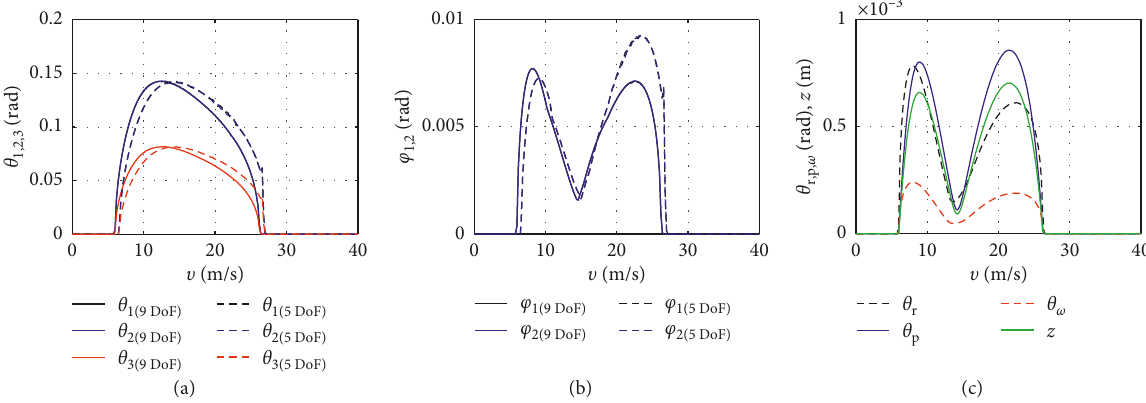
Figure 7: Relationship between the amplitude of each DoF and vehicle velocity. (a) The amplitudes of θ (c) The amplitudes of θ r,p, ω , and z